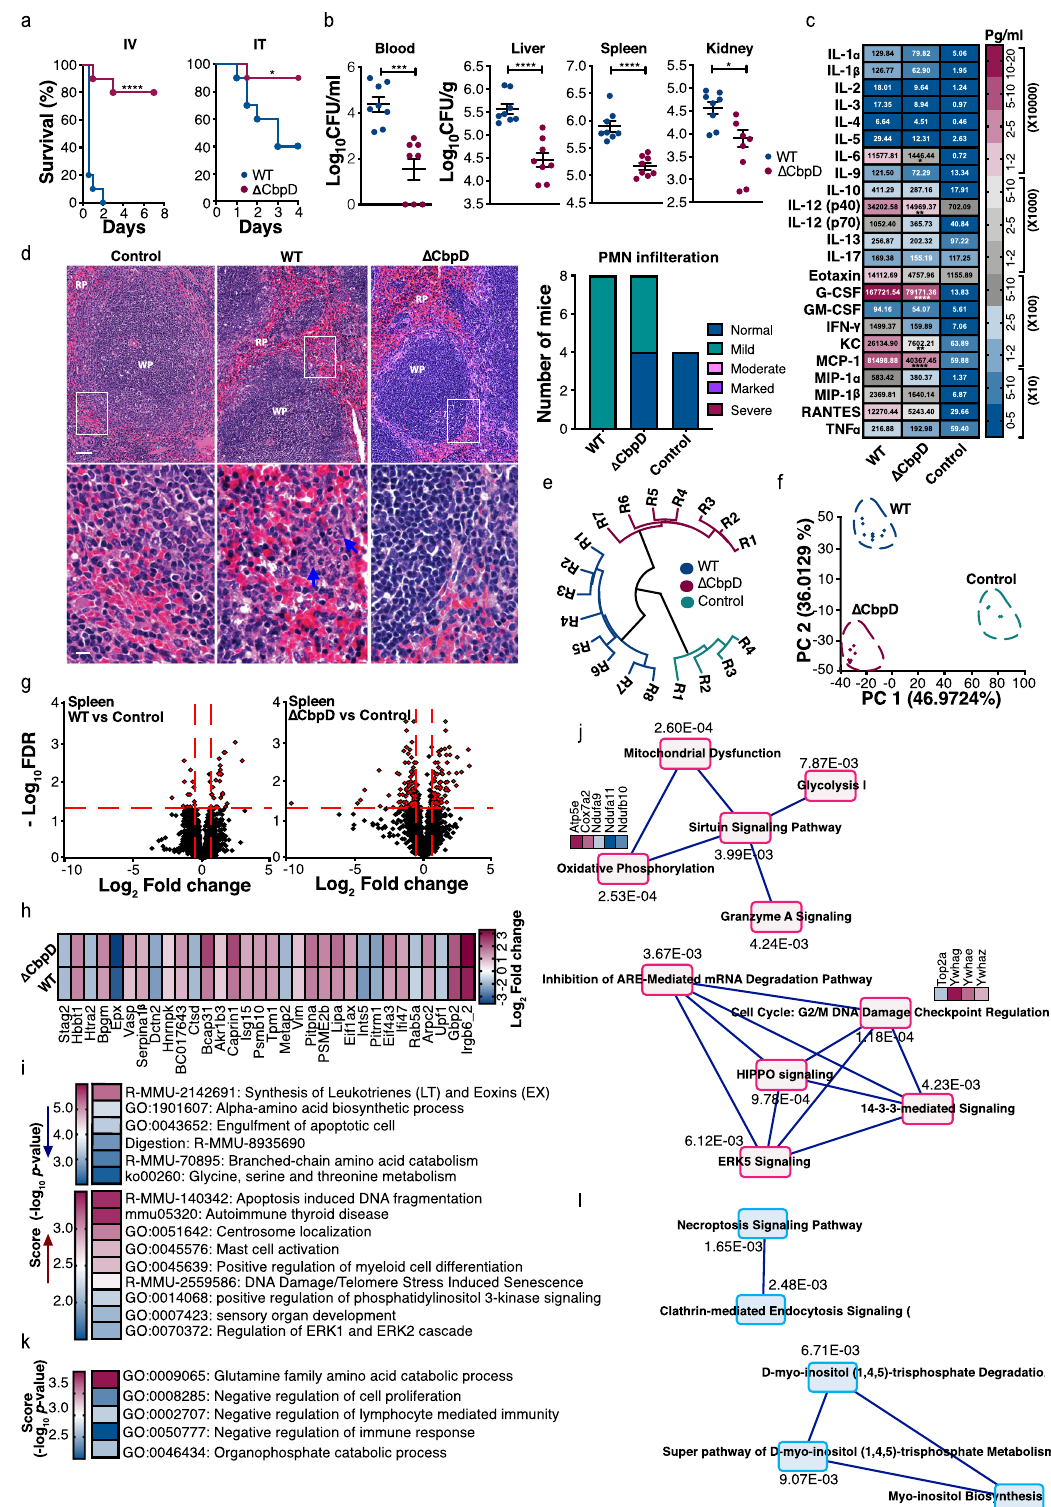
CbpD contributes to PA virulence in murine systemic infection in vivo . Given the contribution of CbpD in resistance of PA to whole blood-mediated killing, we evaluated the impact of CbpD on PA systemic virulence in a murine intravenous (IV) challenge model. CD1 mice (8-week old) infected with 2 × 10 7 CFU/mouse WT PA experienced 100% mortality within 48 h post infection